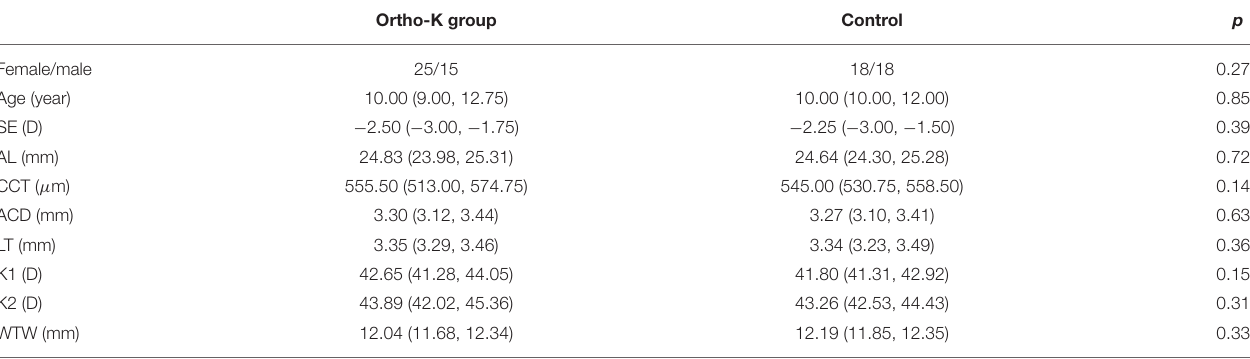
TABLE 1 | Demographic and biometric characteristics at baseline between the two groups. Ortho-K group Control p Female/male 25/15 18/18 0.272